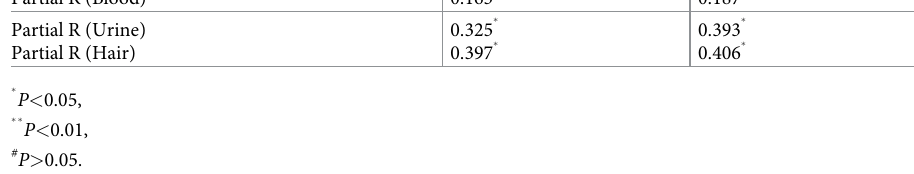
Fig 3. Correlation analysis. (A) Serum pyrrole adducts and gait score of rats treated with 2,5-HD. (B) Serum pyrrole adducts and gait score of rats treated with n -hexane. (C) Urine pyrrole adducts and gait score of rats treated with 2,5-HD. (D) Urine pyrrole adducts and gait score of rats treated with n -hexane. (E) Hair pyrrole adducts and gait score of rats treated with 2,5-HD. (F) Hair pyrrole adducts and gait score of rats treated with n -hexane.